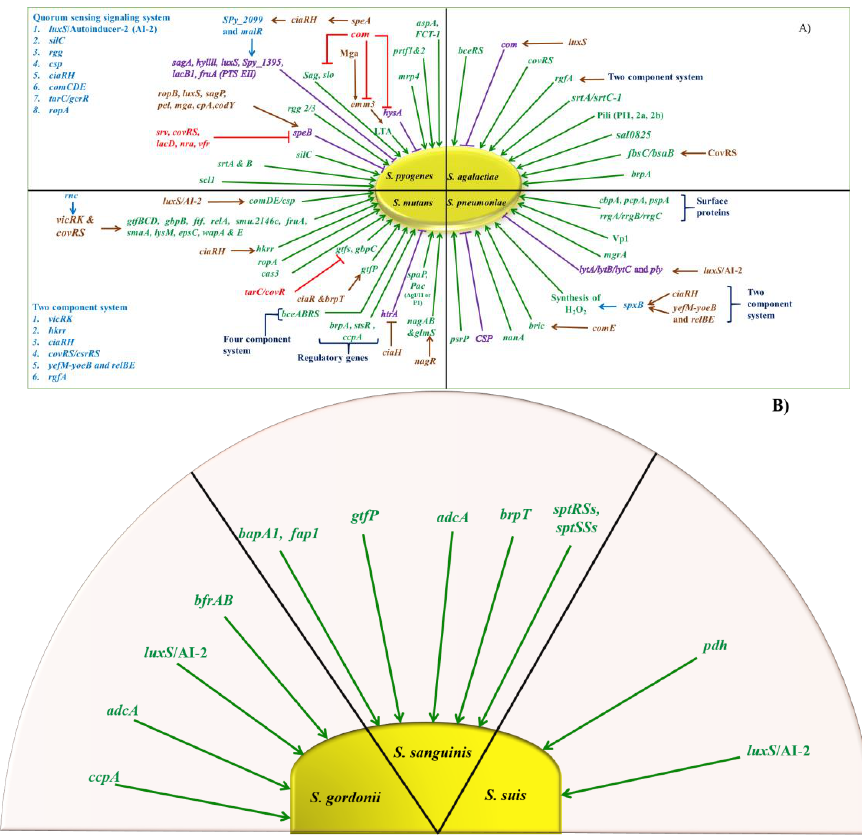
Figure 3. ( A ) Regulation of biofilm in different streptococcal species at the genetic level. The